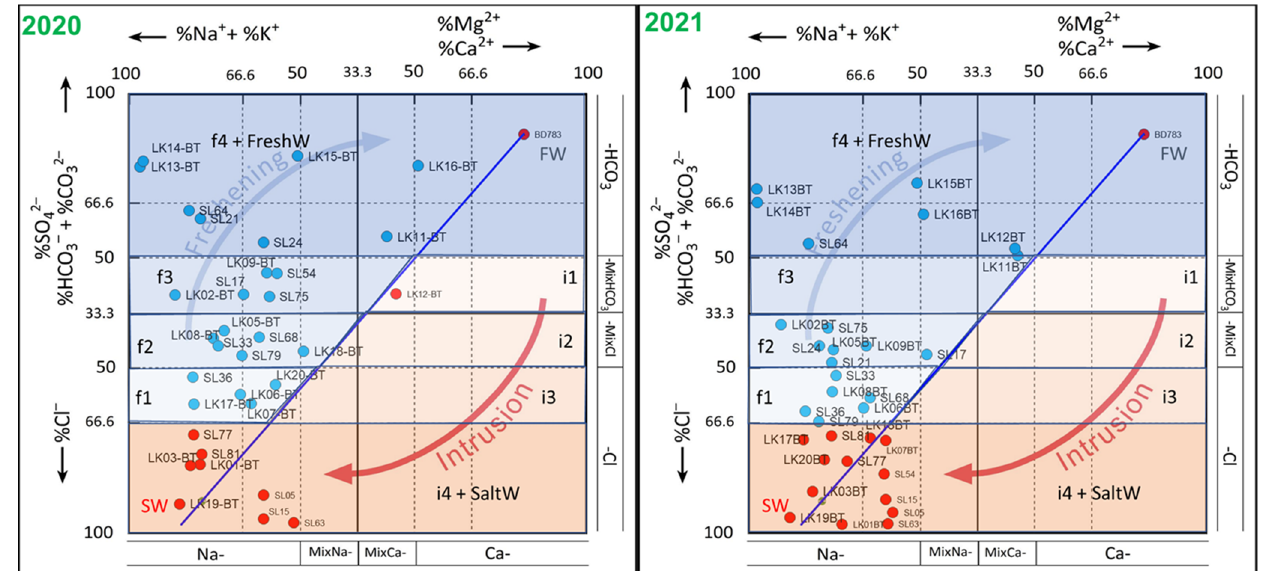
HFE diagram to observe the water faces variation during the time periods (Figure 13).